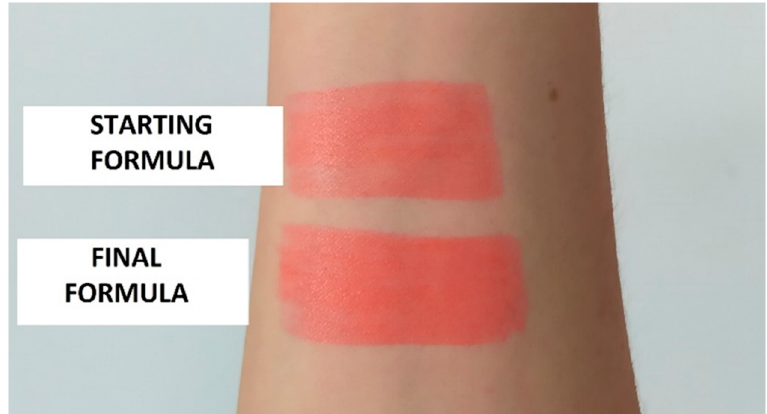
Figure 6. Starting Formula of Lipstick vs. Ref. 1/21/18 (Final formula).